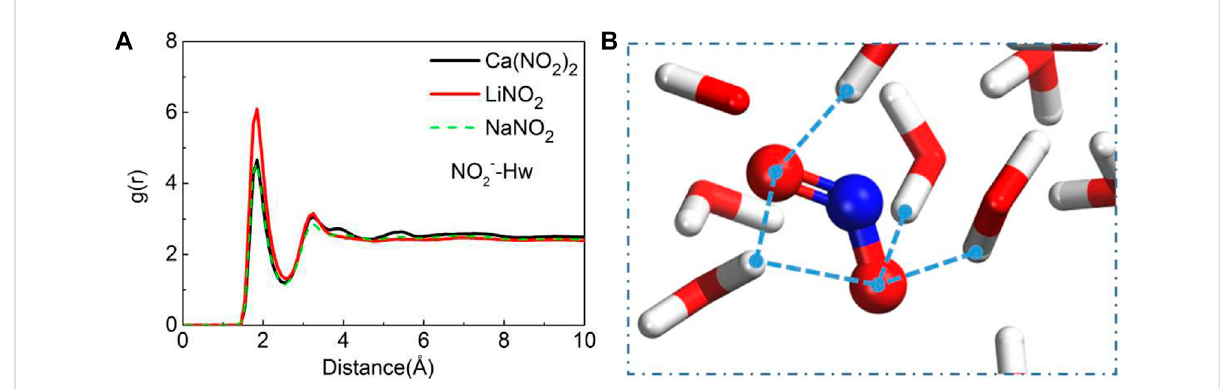
FIGURE 5 The radial distribution function (RDF) of (A) NO 2 − -H w and (B) the H-bonds network of NO 2 − -H w . (The blue balls are for the nitrogen. The red- white sticks are for the water molecule).